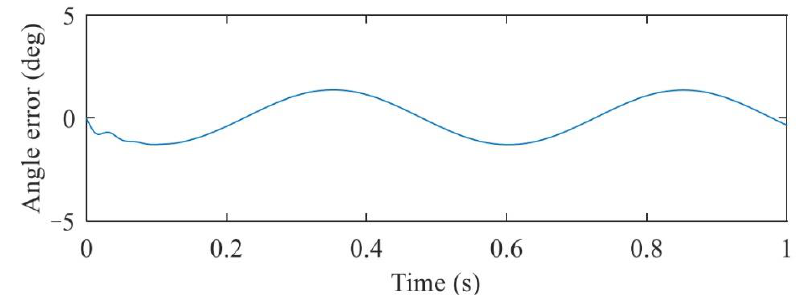
Figure 14. Backstepping HIL simulation error curve (first set of control parameters).